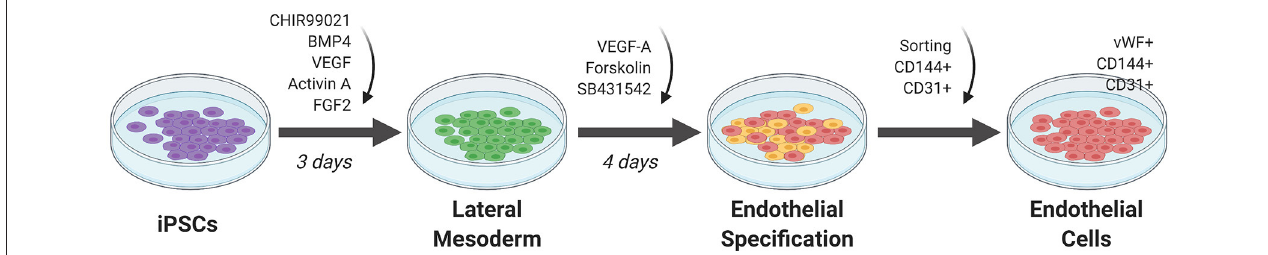
FIGURE 3 | Monolayer method of EC differentiation from iPSCs using small molecules. iPSCs transition to lateral mesoderm through addition of CHIR99021, BMP4, and FGF2 for 3 days. Endothelial specification is induced for 3 to 5 days using VEGF-A, SB431542, and forskolin. Sorting for CD144 + and CD31 + cells generates a pure differentiated EC